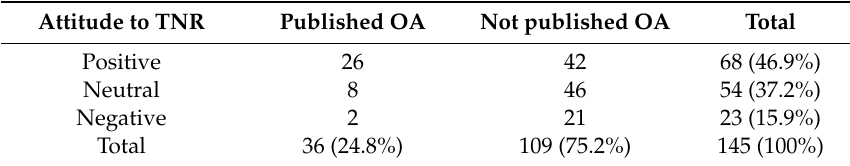
Table 5. Attitudes to TNR in papers published OA and non-OA formats.